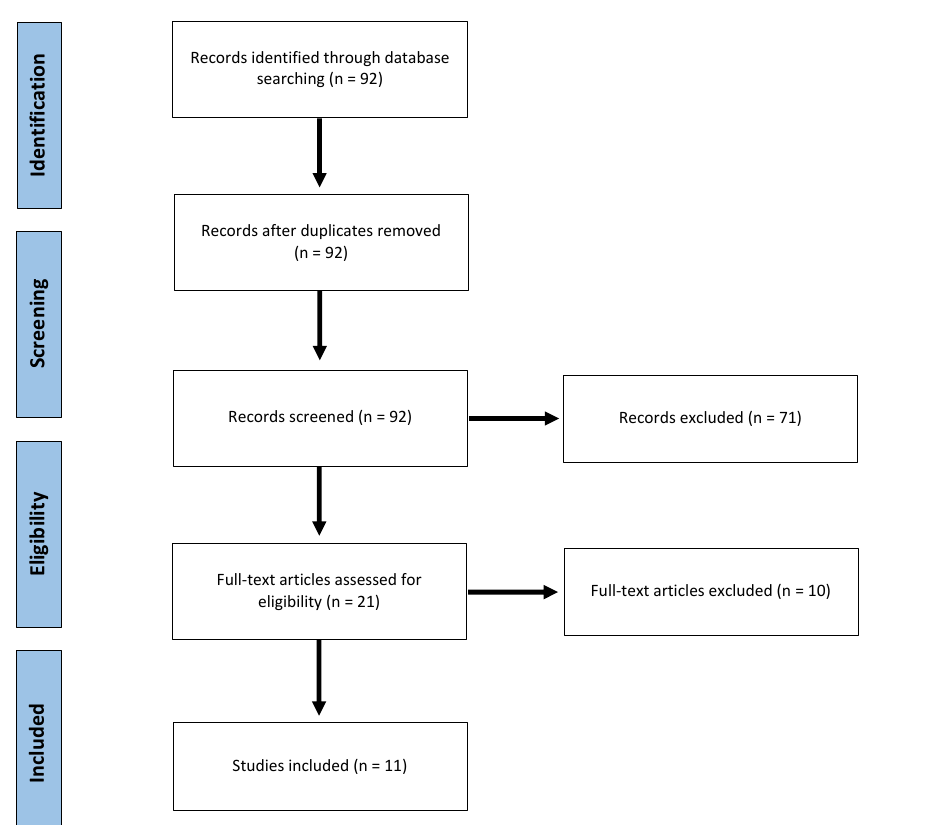
Figure 1. Flow Chart of the inclusion-exclusion process, according to the Preferred Reporting Items for Systematic Reviews and Meta-Analyses.